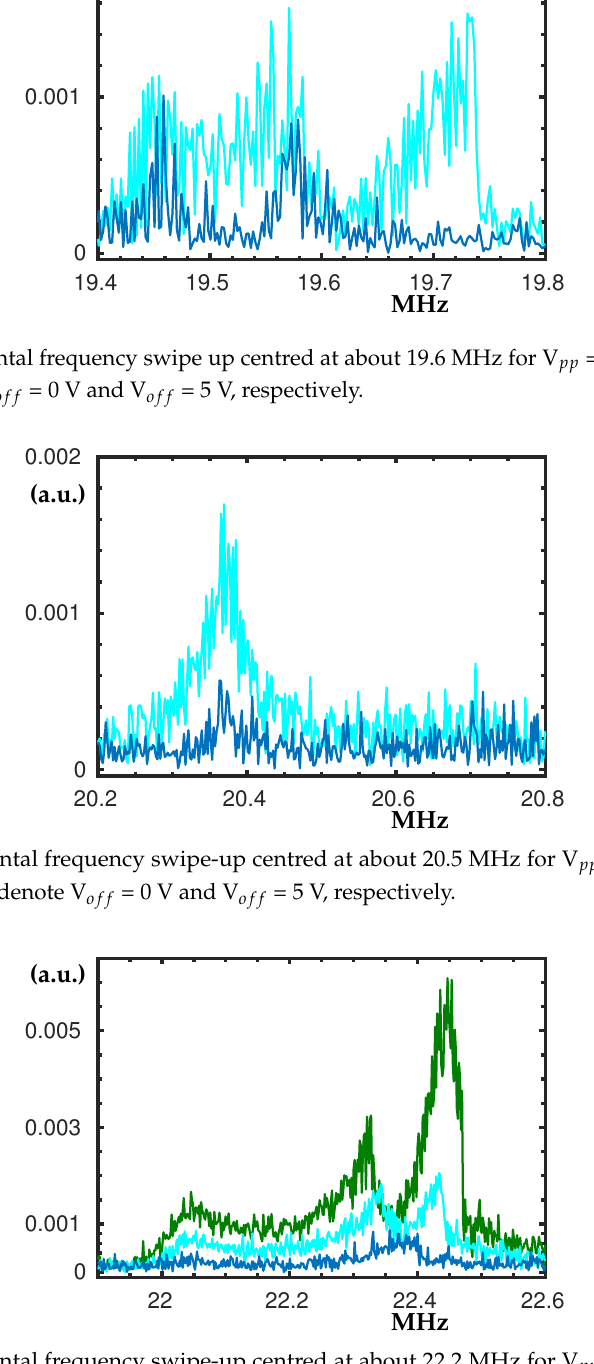
Figure A6. Experimental frequency swipe-up centred at about 22.2 MHz for V pp = 10 V, where the blue, cyan and green curves denote V of f = 1 V, V of f = 3 V and V of f = 5 V,